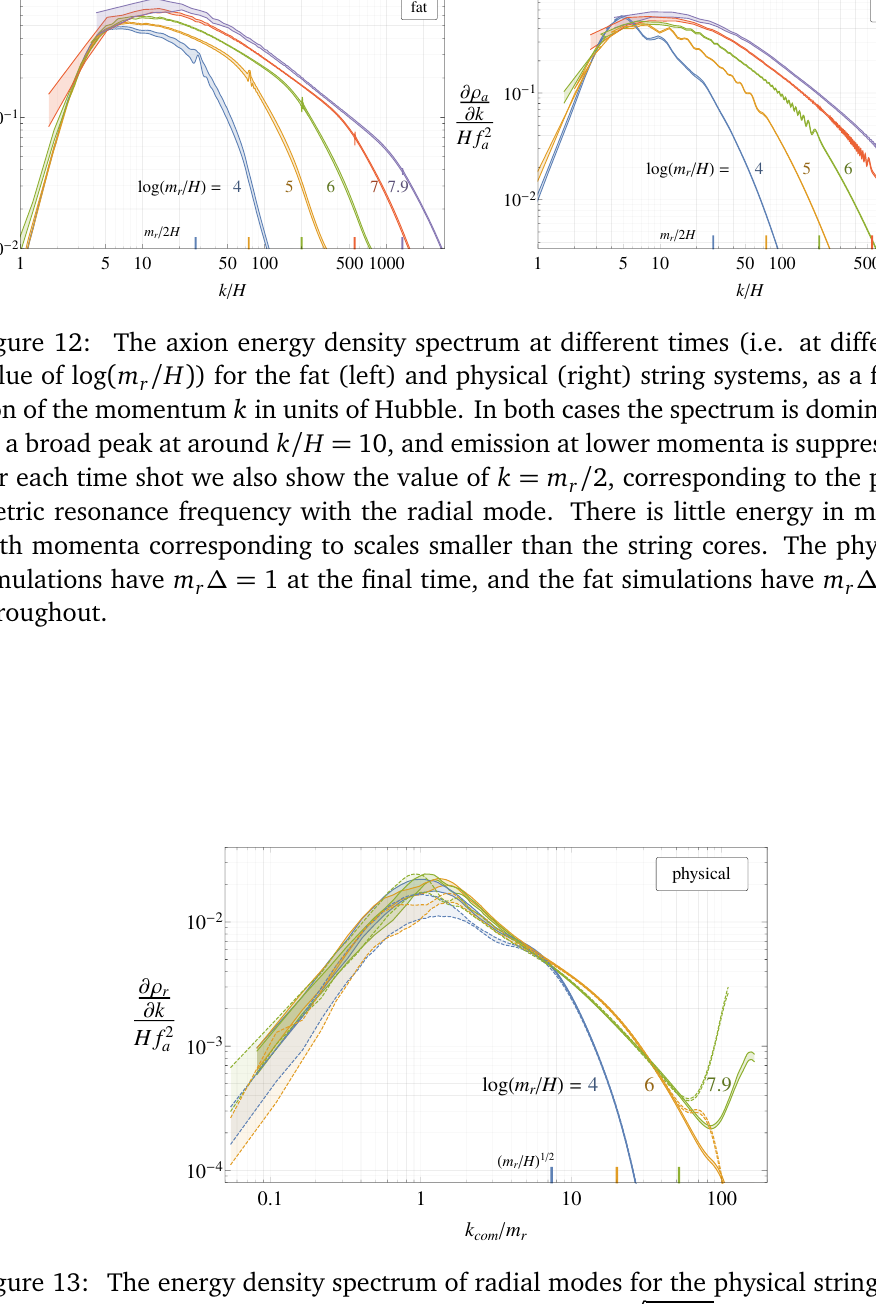
≡ k (cid:112) m / H at different times. r com ∆ = 1, and dashed lines with r f at each of r